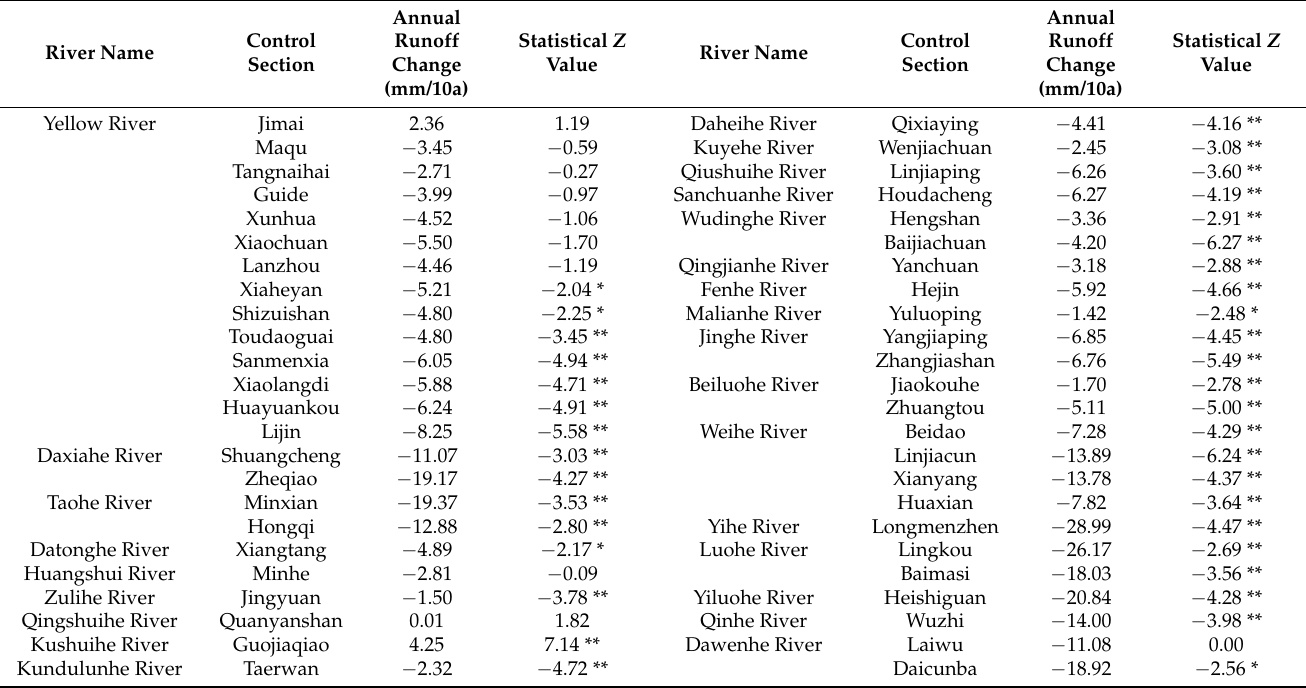
Table 2. Interannual variation of runoff from the main control sections of the Yellow River Basin.